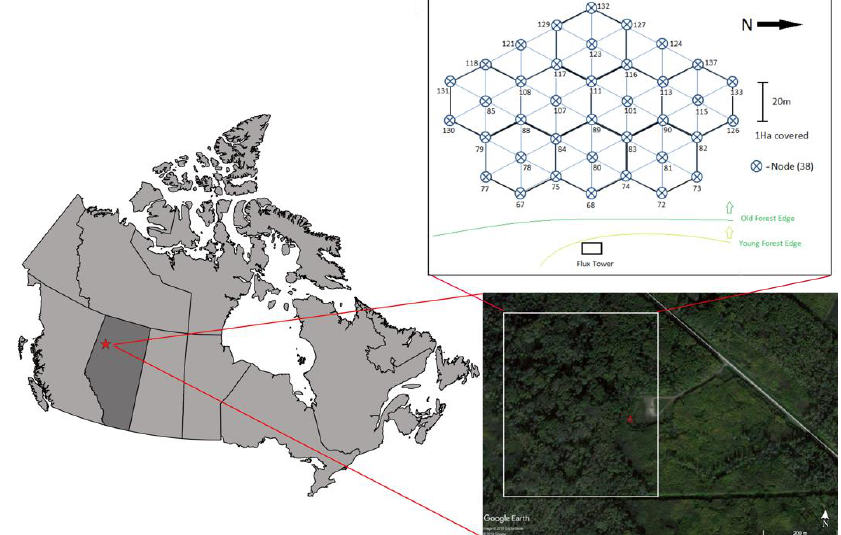
Figure 1. Location of the Peace River Environmental Monitoring Super Site (red star). Red triangle shows the location of the flux tower at the edge of an old growth deciduous boreal forest. The tower contains eddy covariance system, meteorological sensors, and proximal remote sensing sensors. A Wireless Sensor Network (WSN) composing of 36 nodes is located east of the eddy covariance tower, within the flux